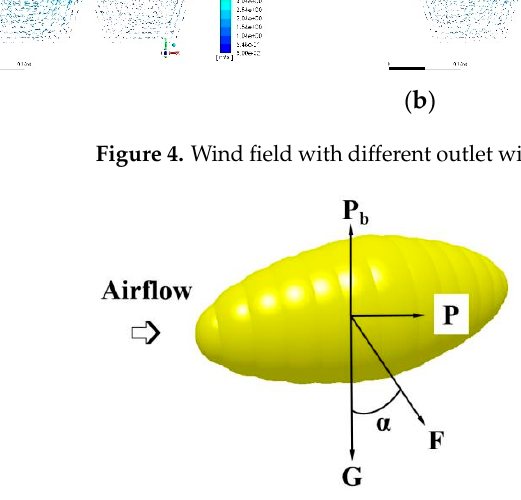
Figure 5. Force analysis diagram of rice grains.